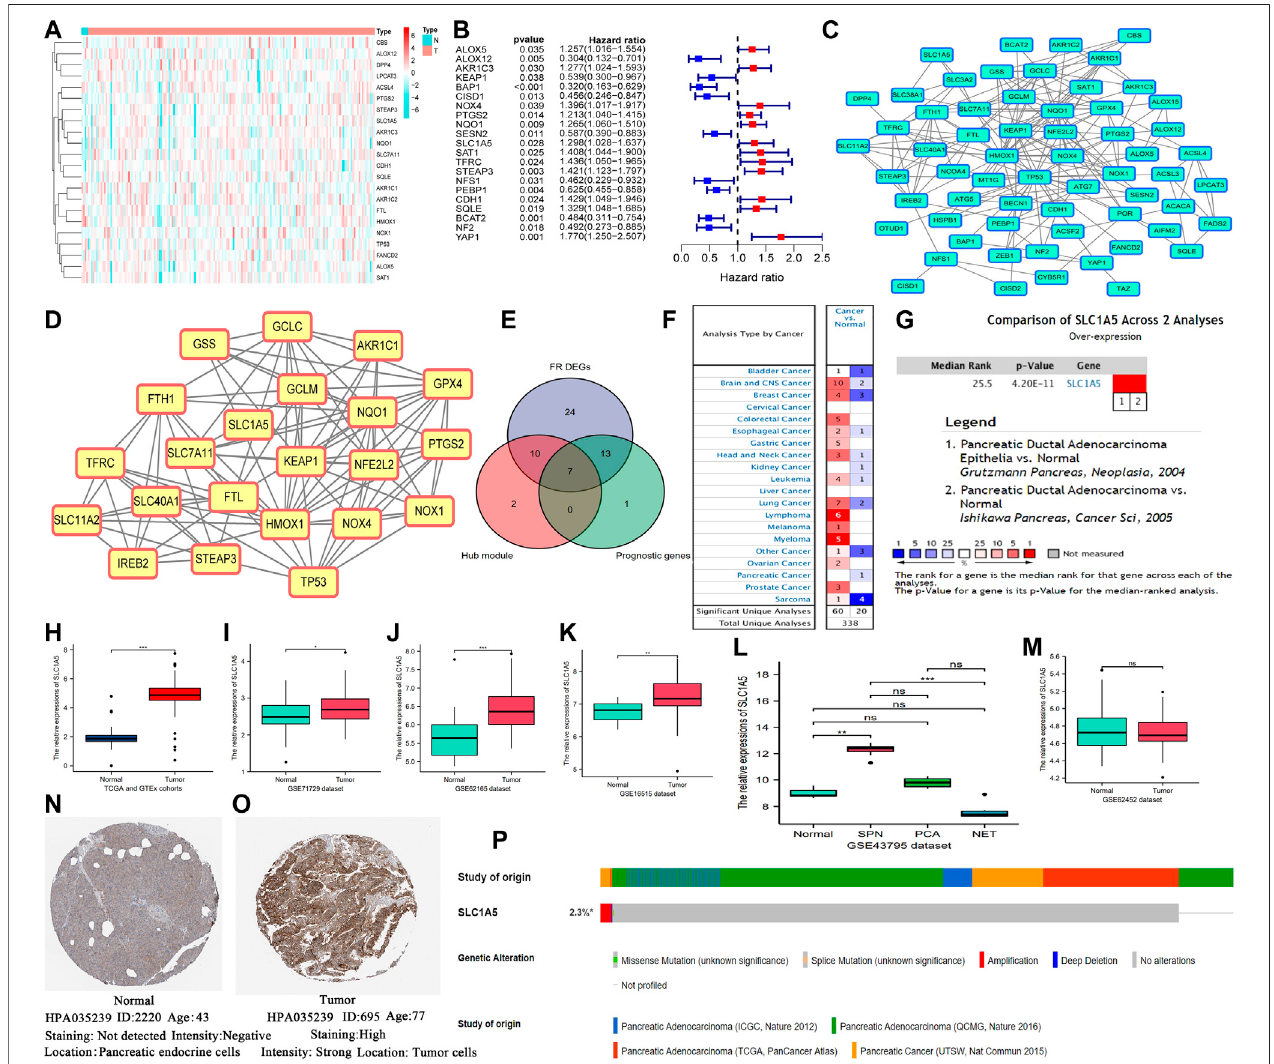
FIGURE 2| SLC1A5is identi fi ed asa crucial regulator in ferroptosis and is signi fi cantly upregulated in PAAD. (A) The heatmap offerroptosis DEGs. (B) Prognosis- related ferroptosis genes. (C) The PPI network of 64 FR genes. (D) The most signi fi cant module in ferroptosis PPI network. (E) The intersection among the hub module, DEGs, and prognostic genes. (F) Pan-cancer analysis of SLC1A5 based on the Oncomine database. (G) A meta-analysis of SLC1A5 expression based on two pancreatic cancer datasets. (H) The expressive difference of SLC1A5 between the normal and PAAD samples in the TCGA cohort. (I – M) The expressive differences ofSLC1A5betweenthenormal andPAADsamplesinmultipleGEO datasets. (N,O) Thehistological expressionofSLC1A5basedontheHPA database. (P) ThesomaticmutationinformationofSLC1A5basedonthecBioPortaldatabase.PAAD,pancreaticadenocarcinoma;DEGs,differentiallyexpressedgenes;PPI,protein- protein interaction; FR, ferroptosis-related; NS, no statistical differences; * p < 0.05, ** p < 0.01, and *** p < 0.001.